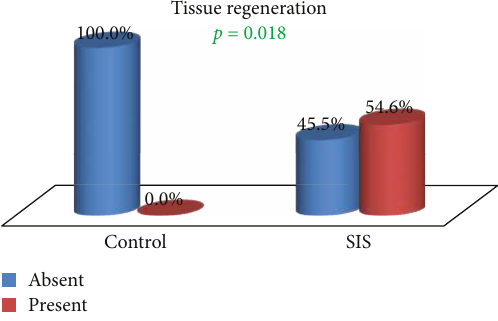
Figure 12: Tissue regeneration: group comparison.